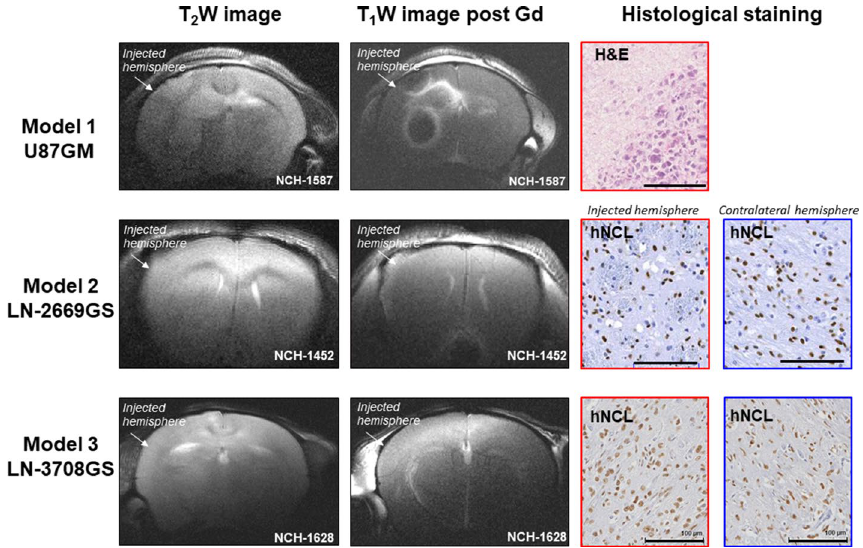
Figure 1. Axial slices of T 2 ‐ weighted images and T 1 -weighted images post injection of gadolinium contrast agent. The arrows indicate the injected hemisphere. As expected, implantation of U87GM cells lead to the development of a focal tumor as confirmed by hematoxylin and eosin (H&E) staining (model 1). Immunochemistry for human Nucleolin (hNCL) that detects human cells, visualizing the highly invasive properties in the injected and the contra ‐ lateral side in models 2 and 3, injected with LN-2669GS and LN-3708GS, respectively. NCH numbers indicate the identification number of each individual